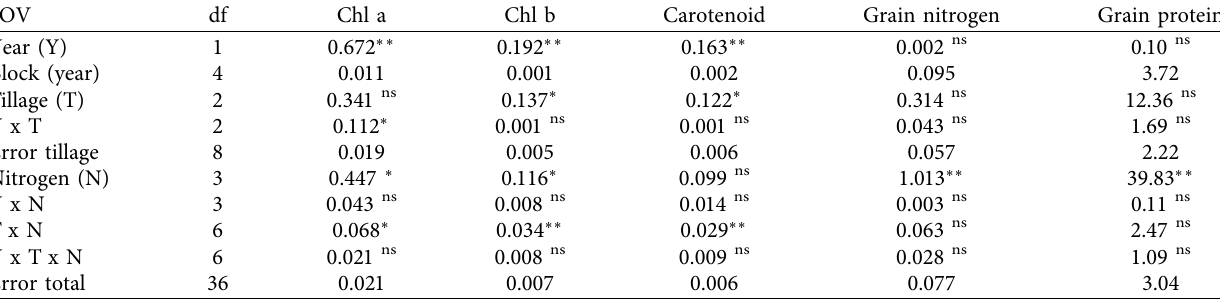
Table 2: Variance analysis of photosynthetic pigments of nitrogen and protein grain of corn in different tillage and nitrogen levels for two years.